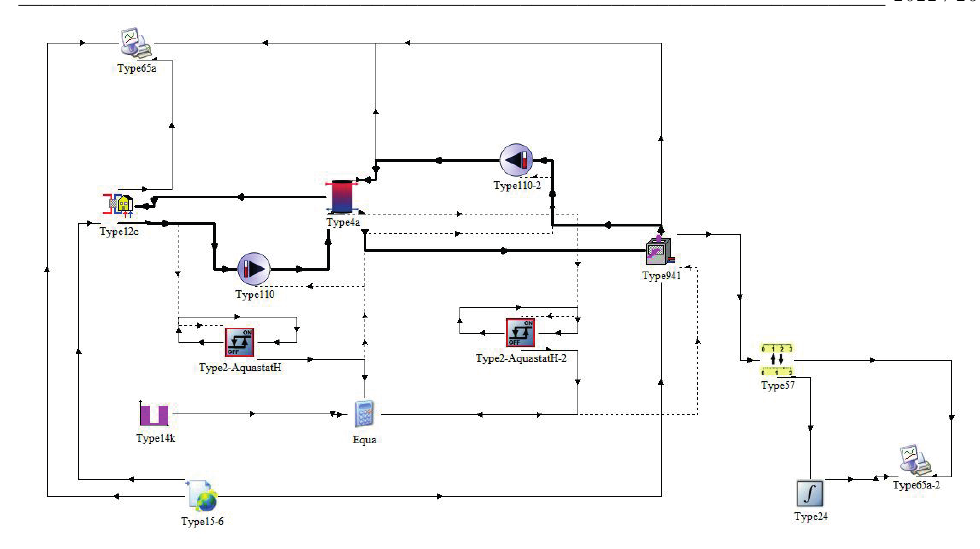
Fig. 1. System model in